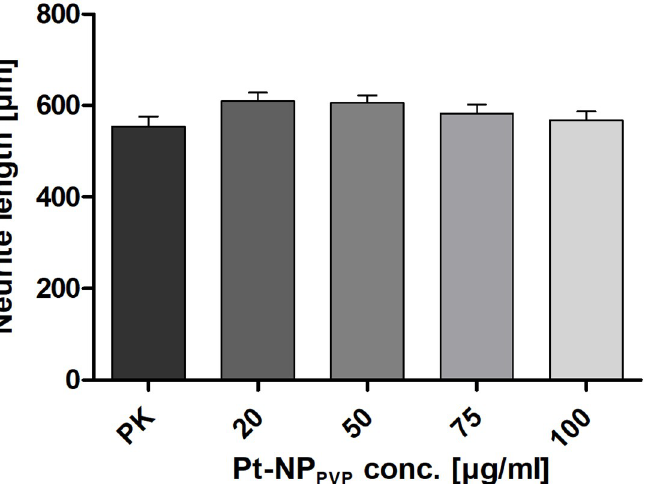
Fig 6. Determination of dose-dependent effects of Pt-NP PVP on the survival rate and neurite outgrowth of the SG neurons cultivated for 48 h. Determination of the impact of varying Pt-NP PVP concentrations on the survival rate (Fig 5) and neuritogenesis of the SG neurons characterized by anti-neurofilament 200 staining (Fig 6) cultivated for 48 h in cell culture medium containing 20 μ g/ml—100 μ g/ml Pt-NP PVP . Each data point is presented as mean and SEM of the (Fig 5) percentage of stained SG neuron soma in cell culture assays supplied with Pt-NP PVP (N = 6, n = 18 of each Pt- NP PVP concentration) in relation to the reference without Pt-NP PVP administration and (Fig 6) length of nerve fibres (N = 6, n = 90 neurons exposed to varying Pt-NP PVP concentration, respectively). One-way ANOVA with Tukey’s multiple comparison test was performed for statistical assessment. The dashed line in (Fig 5) represents the cytotoxicity limit (70%).